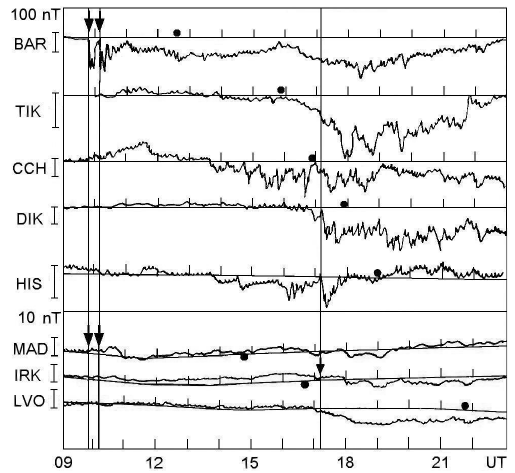
Figure 31. Magnetograms of auroral (from top to bottom: Point Barrow, Tixie Bay, Cape Chelyuskin, Dixon Island, Heiss Island) and midlatitude stations (Magadan, Irkutsk, Lvov) on 3 December 1973. The vertical lines indicate the initiation moments of Pi2 pul- sation trains in midlatitudes (Sergeev and Vorobjev,